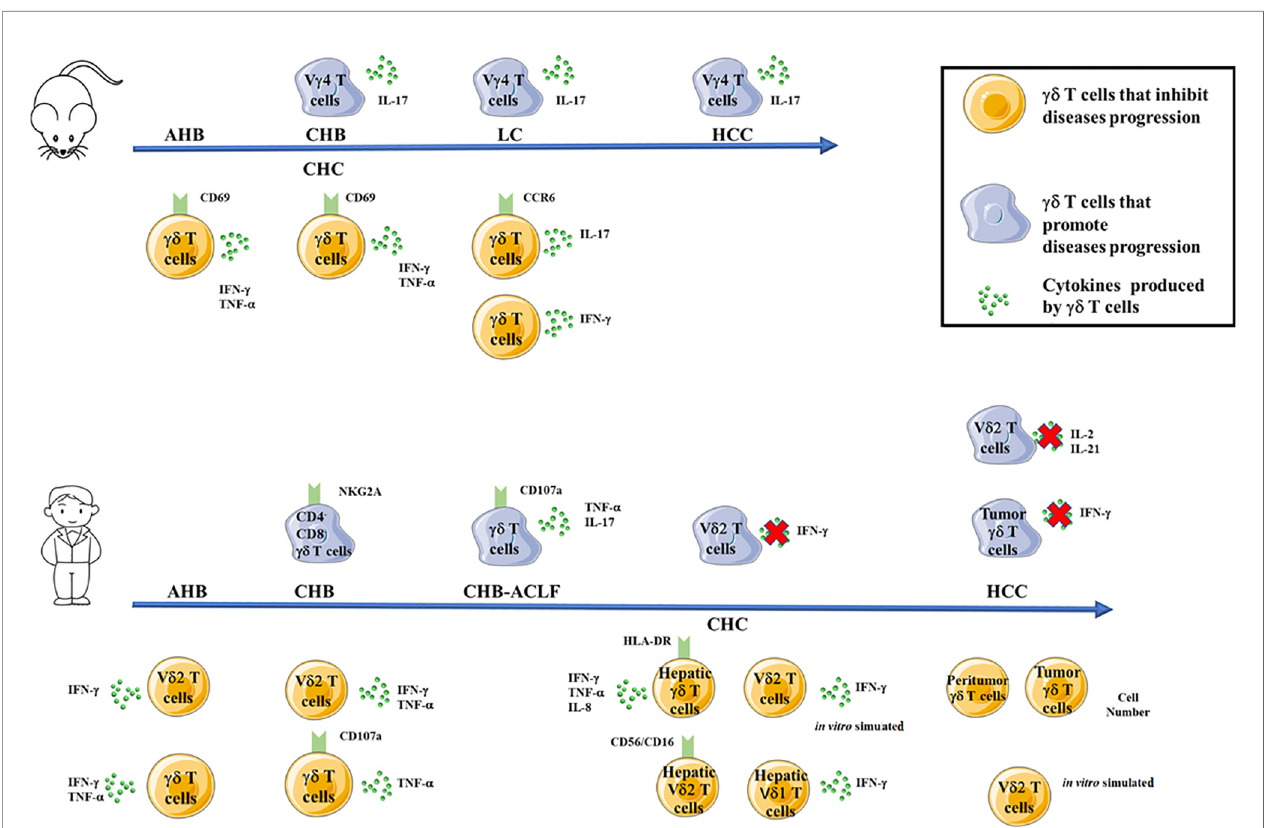
FIGURE 1 | Functions of mouse (top) or human (bottom) gd T cells and their subsets in inhibiting (yellow cells) or promoting (blue cells) the pathogenesis of HBV or HCV infection. The arrows indicate the progression of HBV or HCV infections, the red fox indicate impaired secretion of cytokines by gd T cells and their subsets. AHB, acute hepatitis B infection; CHB, chronic hepatitis B infection; CHB-ACLF, HBV-associated acute-on-chronic liver failure; CHC, chronic hepatitis C infection; LC, liver cirrhosis; HCC, hepatocellular